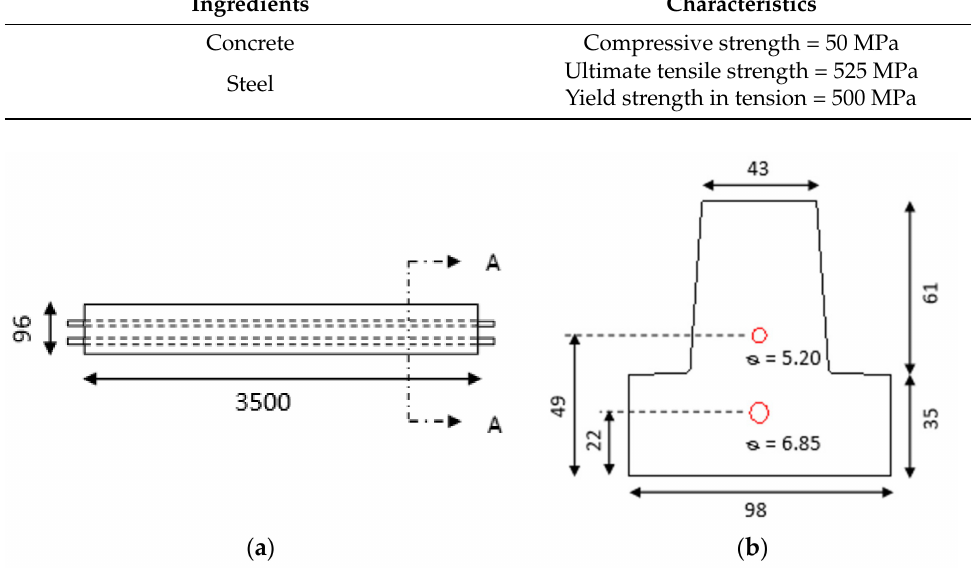
Figure 4. Dimensions of the reinforced concrete T-beam (in mm): ( a ) longitudinal and ( b ) cross sectional dimensions.